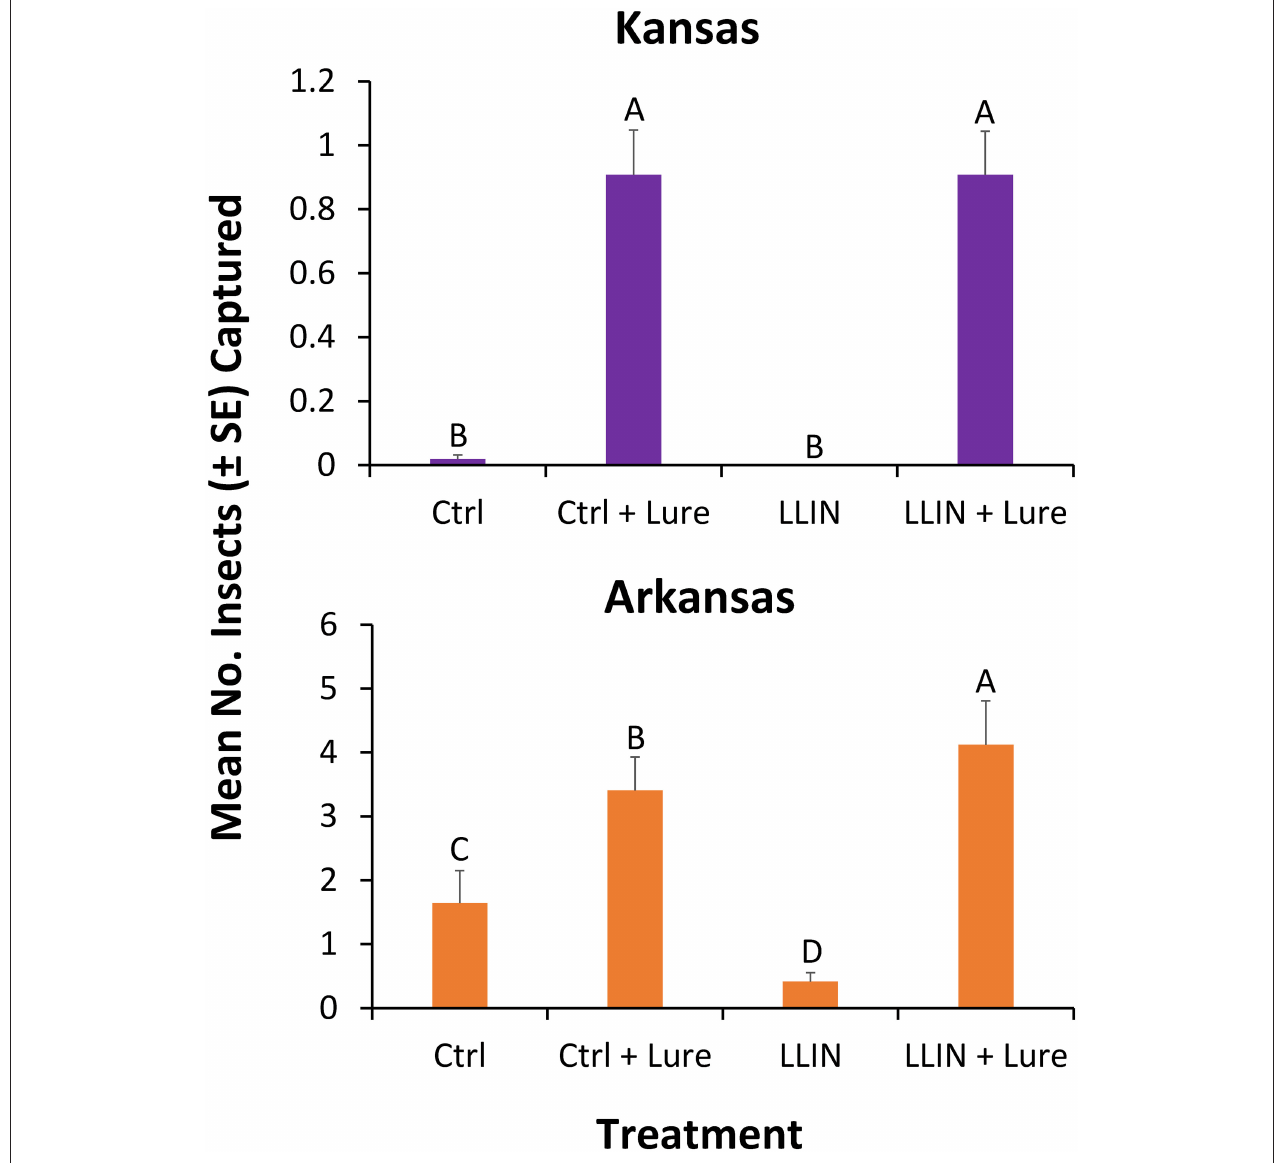
FIGURE 6 | Mean ( ± SE) number of stored product insects captured by interception configuration. Traps were deployed for 48-h periods once every other week at six sites during 2018 and 2019 in in Kansas (top) and Arkansas (bottom) at commercial food facilities. Treatments included interception traps (1) with control netting and no lure (Ctrl), (2) control netting + SPB Tab (Ctrl + Lure), (3) with LLIN and no SPB Tab (LLIN), (4) with LLIN + SPB Tab (LLIN + Lure). Bars with shared letters are not significantly different from each other ( χ 2-tests, Bonferroni